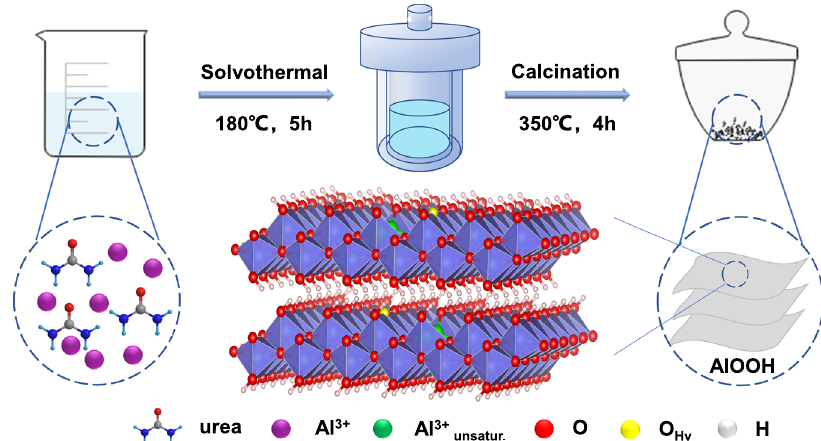
Fig. 1 Catalyst preparation. Schematic process for the fabrication of AlOOH catalyst.